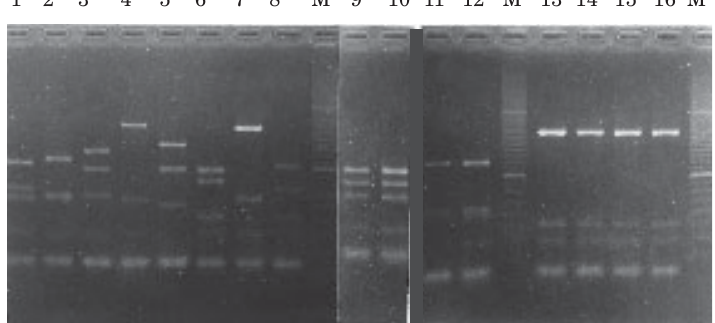
Fig. 1. ITS-RFLP patterns of Phaeoacremonium aleophilum , P. inflatipes , P. parasiticum and unidentified iso- lates using restriction endonuclease Hha I. Lanes 1-8: unique patterns (CBS 694.88, T16, Arg.2, Arg.0, Arg.3, CBS 408.78, CBS 428.95, Arg.5). Lane 9: P.aleophilum (Type strain CBS 246.91). Lane 10: P. angustius (Type strain CBS 249.95). Lanes 11 and 12: P. inflatipes (Type strain CBS 391.71, LCP 96 3899). Lanes 13-16: P. parasiticum (Type strain IMI 181 115, CBS 736.94, CBS 139.69, CBS 651.85). M, size marker (high-intensity bands: 200 and 500